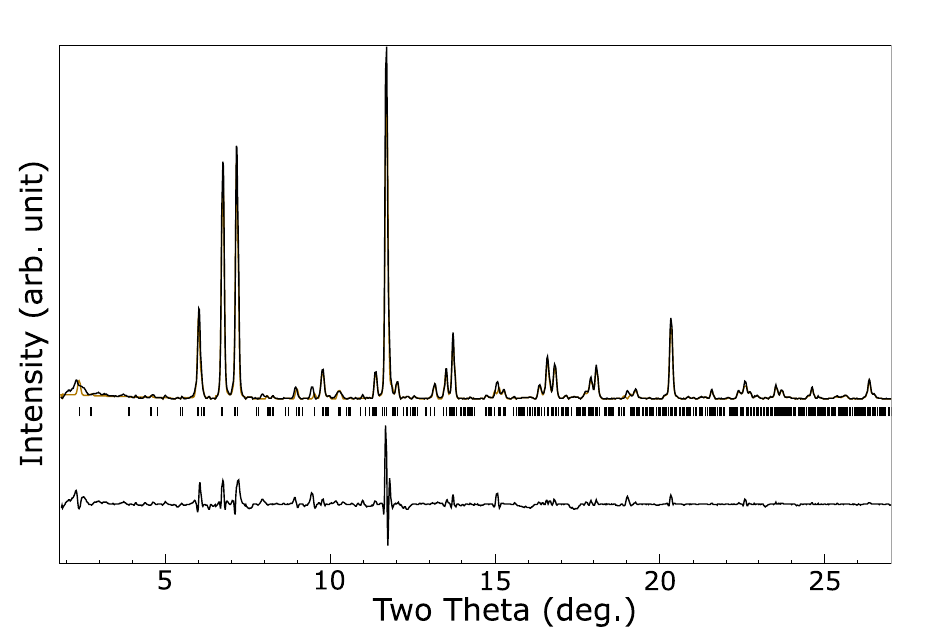
Figure 3. Integrated diffraction pattern of the lithium–palladium intermetallic at ambient temperature and 8.64 GPa (black), with LeBail fit to a face centered tetragonal phase with a = 17.656 and c = 17.868 Å (orange) and residual on same scale (lower black line). Allowed peak positions are indicated by ticks. The unit cell is expressed as face centered tetragonal rather than the equivalent, smaller volume, body centered tetragonal cell to ¯ 43 m aid comparison to the F phase fitted in Fig.